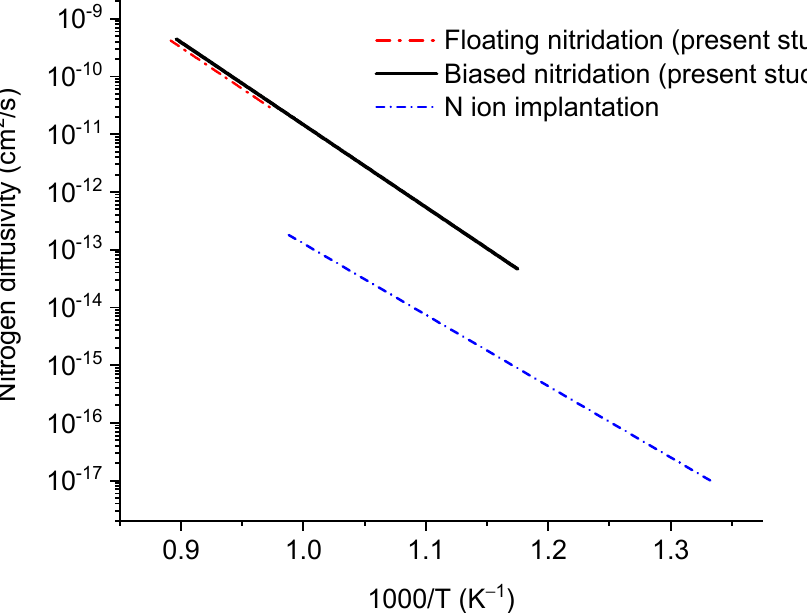
Figure 11. Comparisons of nitrogen diffusivity in Zircaloy-4 for floating nitridation and biased nitridation, both from the present study, and nitrogen diffusivity in α -Zr from a previous nitrogen ion implantation study.